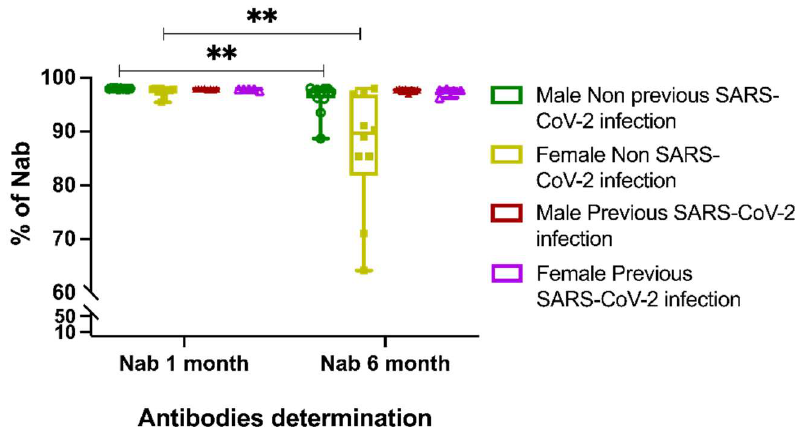
Figure 2. Neutralizing antibodies in the studied population. Female participants, likewise to non- previous COVID-19 groups, showed the greatest loss of neutralizing antibodies in comparison to previous COVID-19 groups and males. Differences between groups were determined by Mann– Whitney U test with an α = <0.05; ** p = 0.01–0.001.